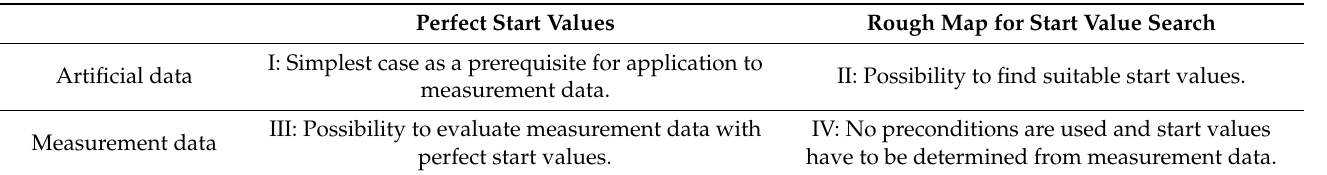
Table 5. Comparison for usage of the perfect start values and the start value search for the artificial and measurement